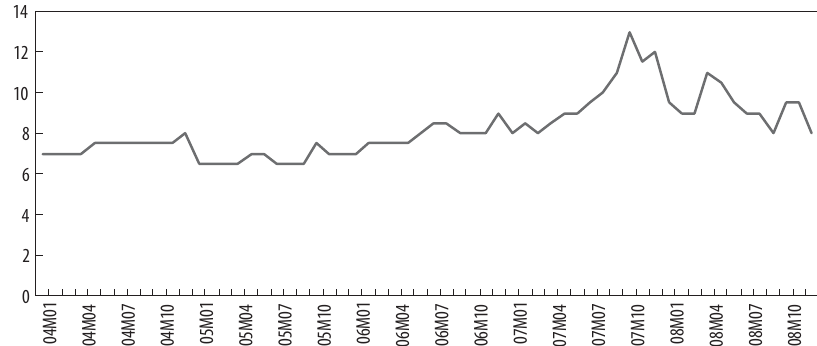
Figure 2. Time series plots of income